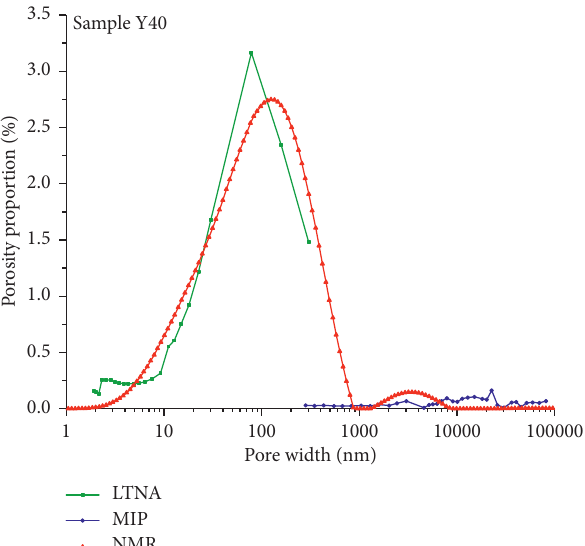
2 adsorption/desorption (LTNA), mercury injection porosimetry (MIP), and